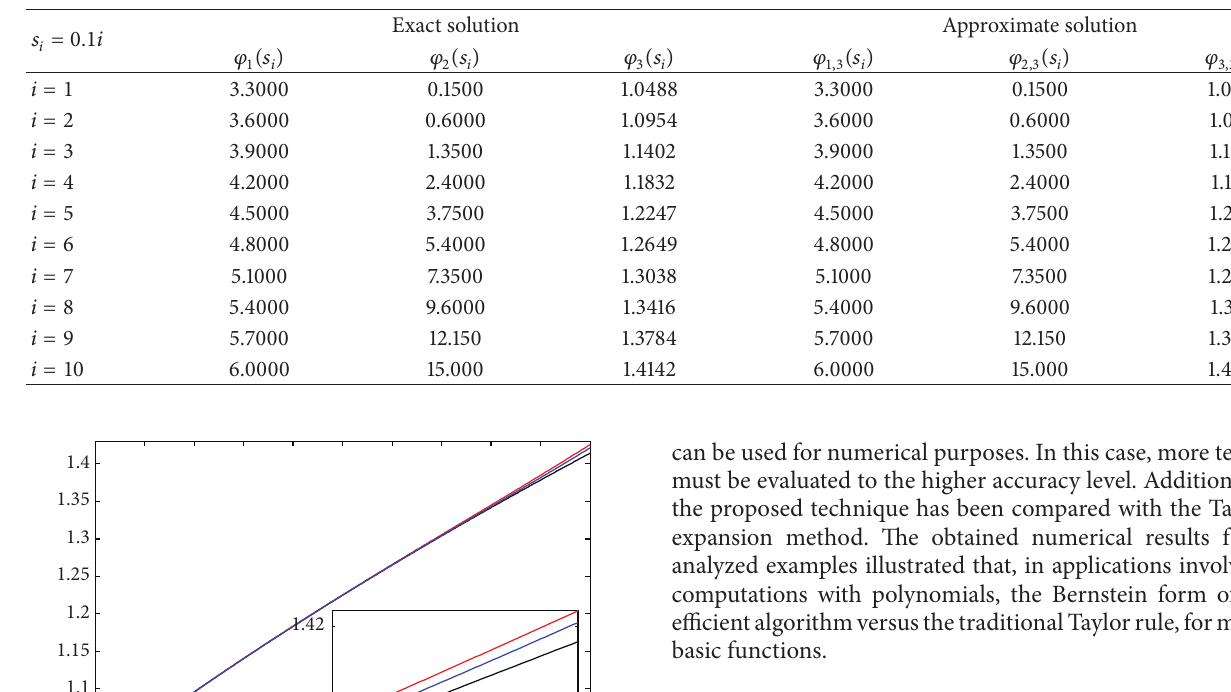
Table 2: Numerical results for Example 3.